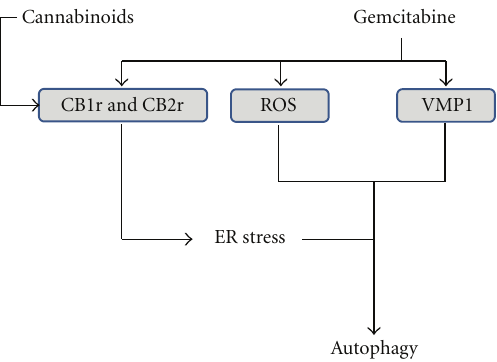
Figure 4: Autophagy of stromal cells fuel PDAC cells. PDAC release ROS to the tumoral microenvironment to induce autophagy in stromal cells. As consequence, stromal cells provide PDAC cancer cells with a steady stream of recycled nutrients and energy-rich